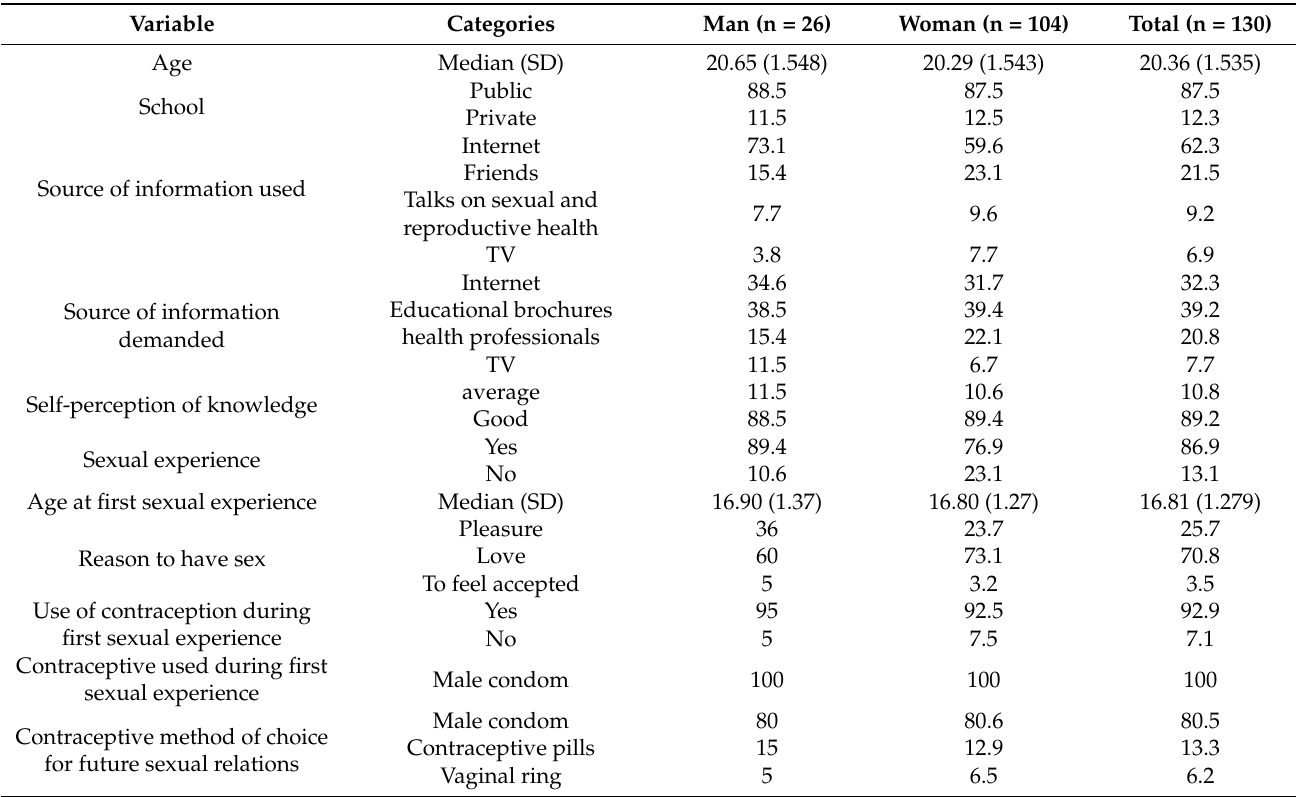
Table 1. Characteristics of the